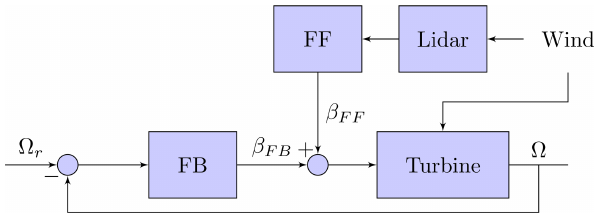
Figure 1. Block diagram of a lidar feedforward collective pitch controller to assist a traditional feedback